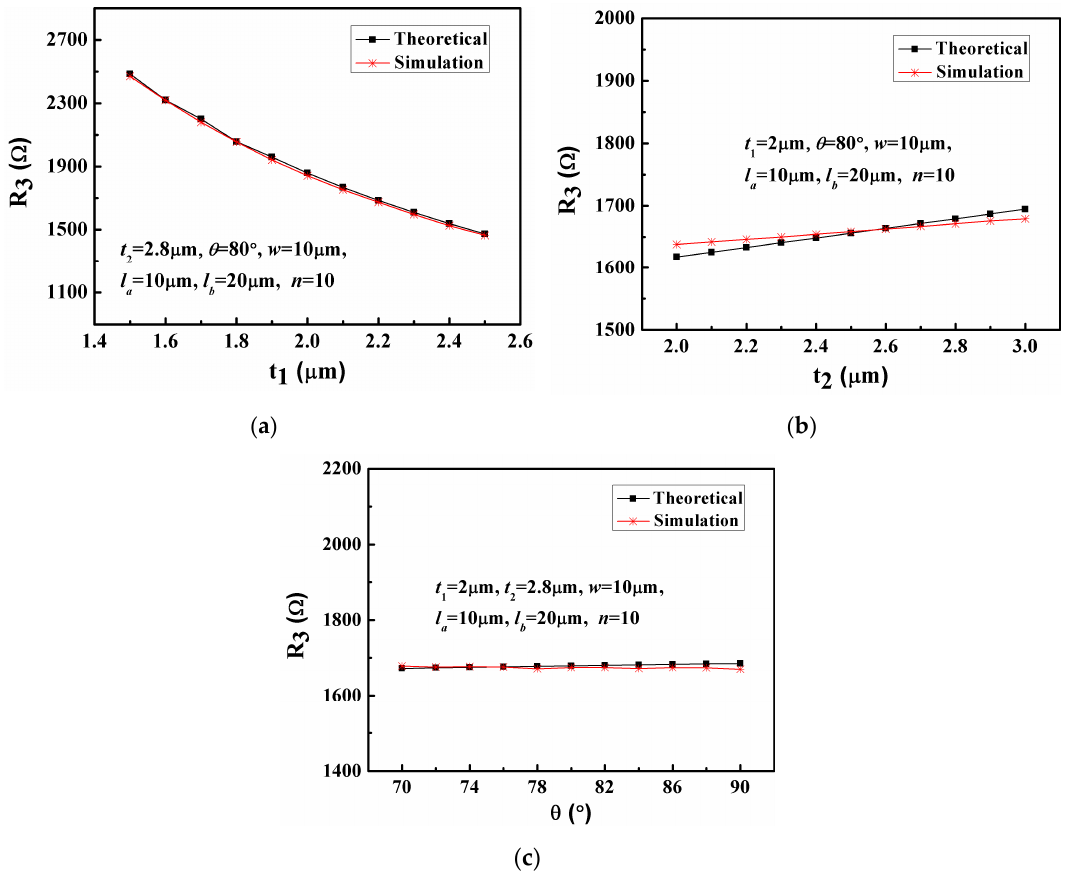
Figure 8. Theoretical and simulation results of the relationship between R 3 and the geometrical parameters: ( a ) The thickness of the polysilicon layer ( t 1 ); ( b ) The thickness of the PSG layer ( t 2 ); ( c ) The sidewall etch angle of the PSG layer ( θ ).